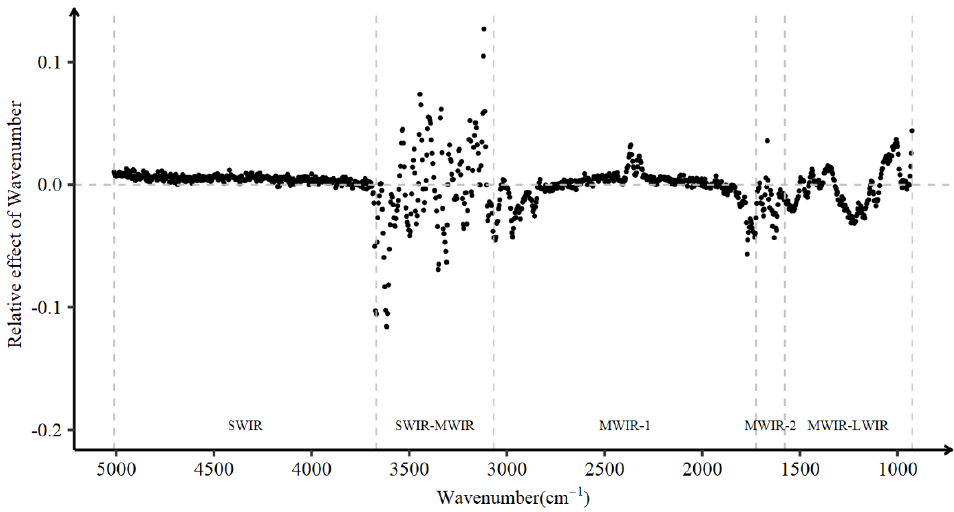
Figure 3. Relative effect of 1060 wavenumbers on DO. SWIR, short-wavenumber infrared or near-infrared; MWIR, mid-wavenumber infrared; LWIR, long-wavenumber infrared.